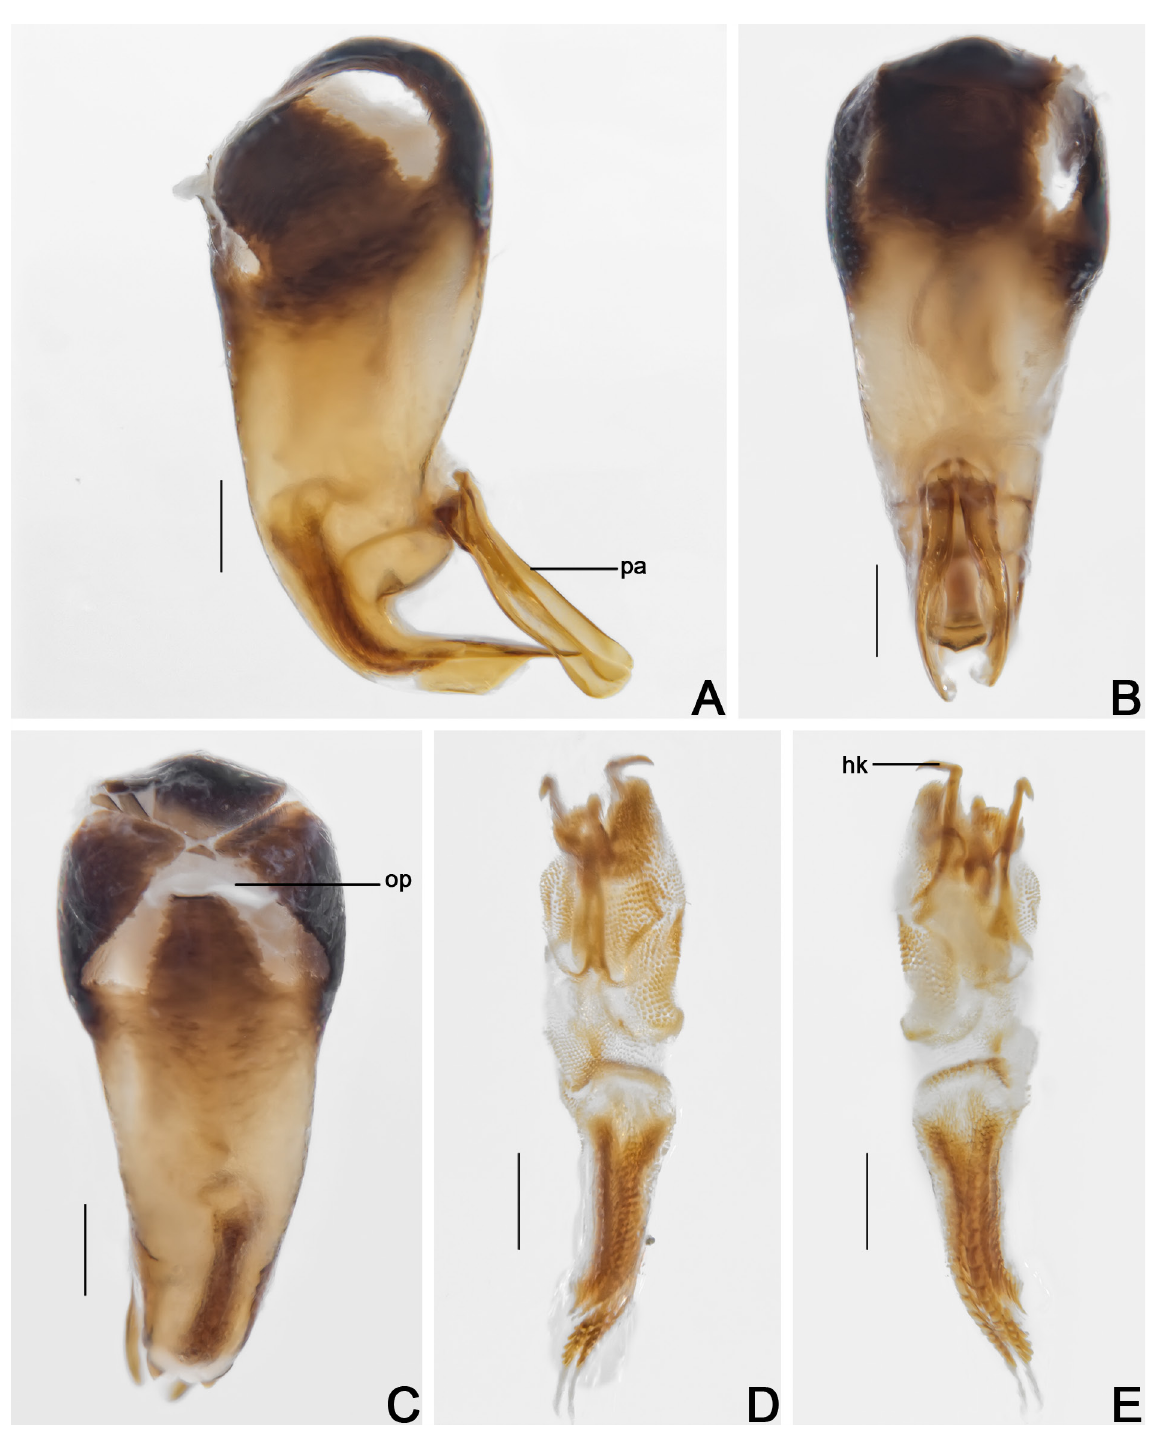
Fig. 12. Cyparium achardi sp. nov., paratype, ♂ (CELC): aedeagi. A . Lateral view. B . Frontal view. C . Dorsal view. D . Internal sac, frontal view. E . Internal sac, dorsal view. Specimen collected at Mata do Paraíso, Viçosa (MG, Brazil). Abbreviations: hk = hook; op = opening; pa = parameres. Scale bars = 0.2